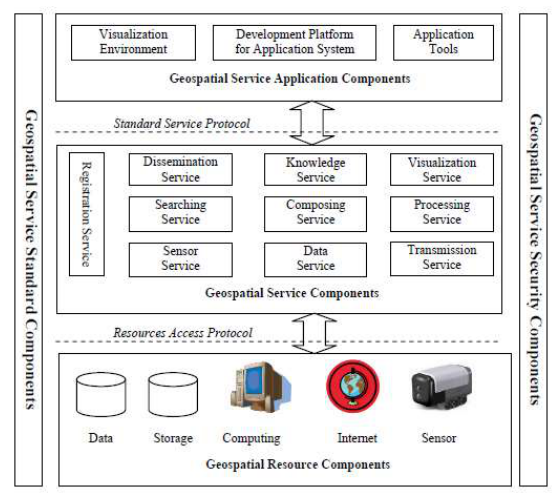
Figure 2. Geospatial services components (Gong et. al, 2009).